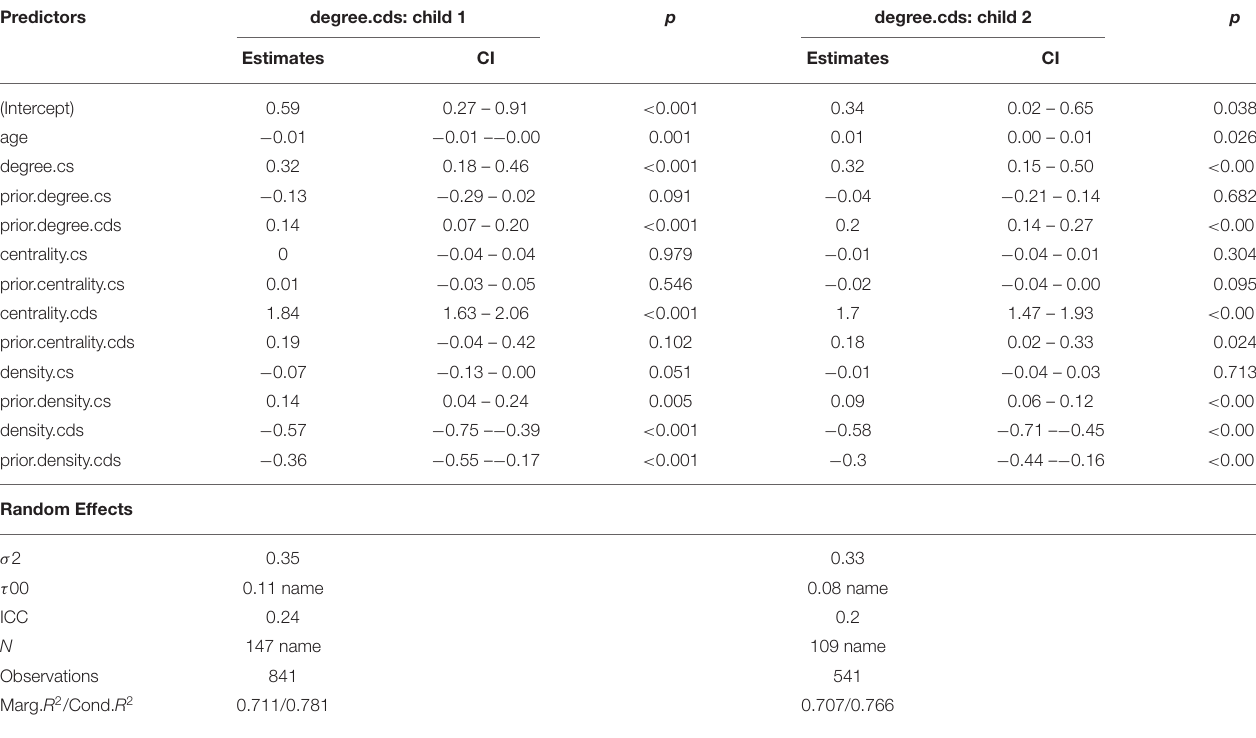
TABLE 7 | Linear mixed model: CDS node